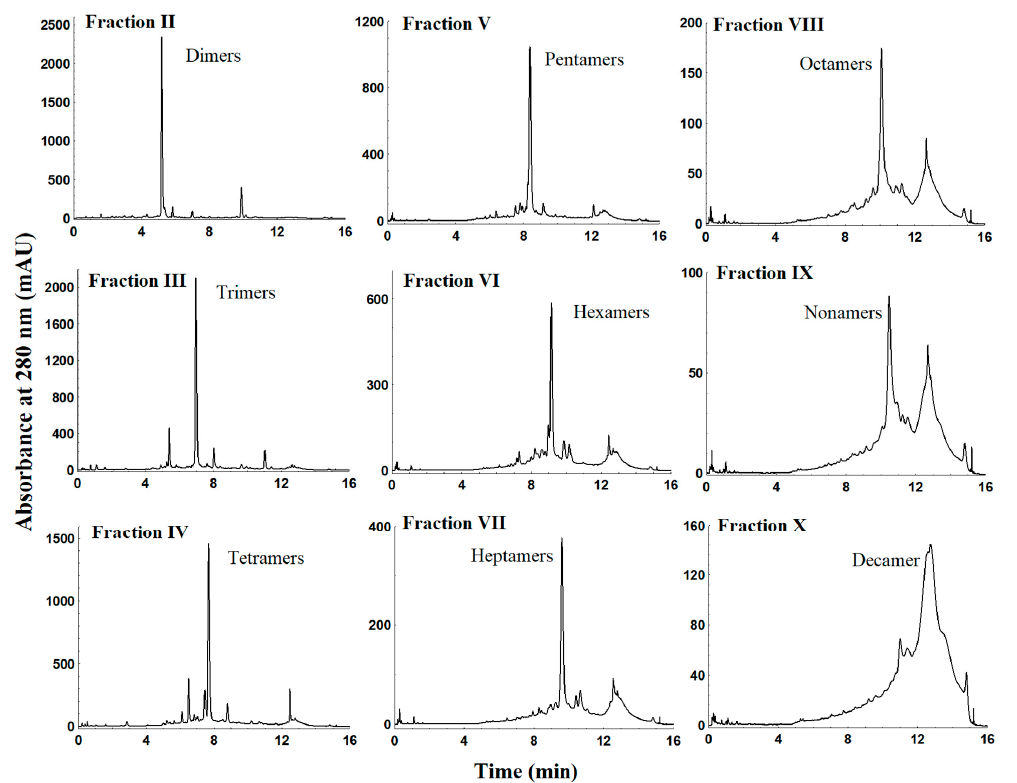
Molecules 2020 , 25 , x FOR PEER REVIEW Figure 4. UHPLC profiles of oligomeric fractions obtained using a diol column. Figure 4. UHPLC profiles of oligomeric fractions obtained using a diol column.